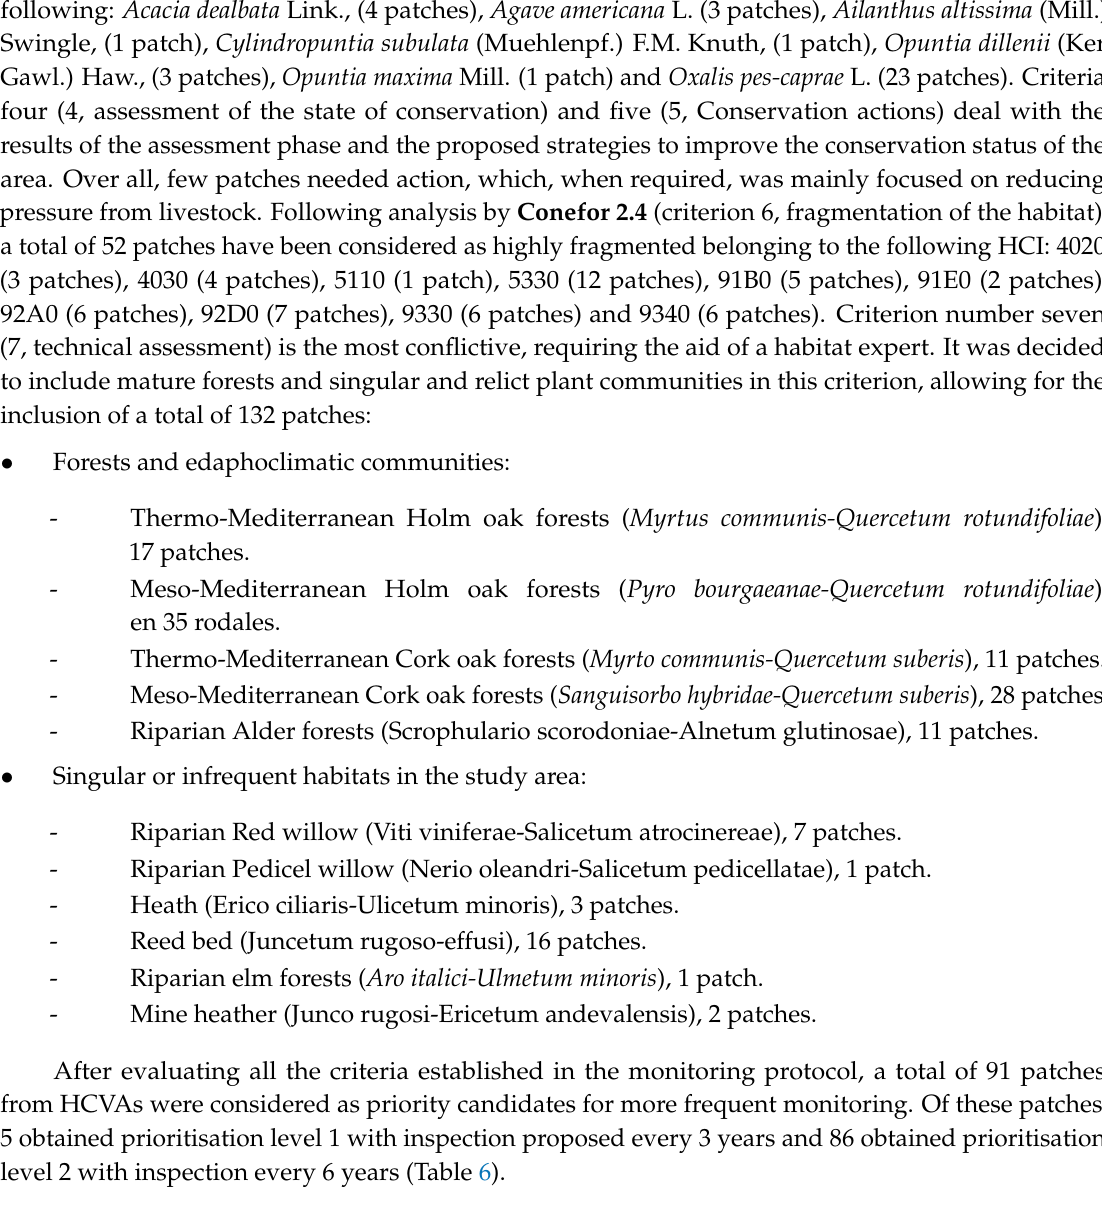
Table 6. Prioritisation levels and number of patches of each